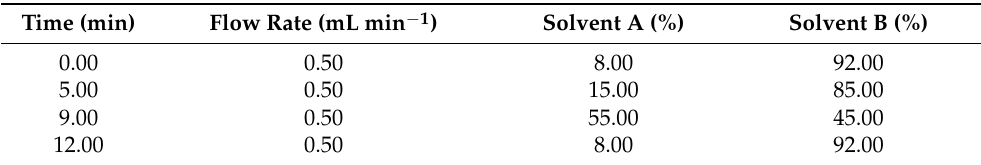
Table 1. Gradient elution program of mobile phases for the separation of sulfonamides by UHPLC-MS/MS.